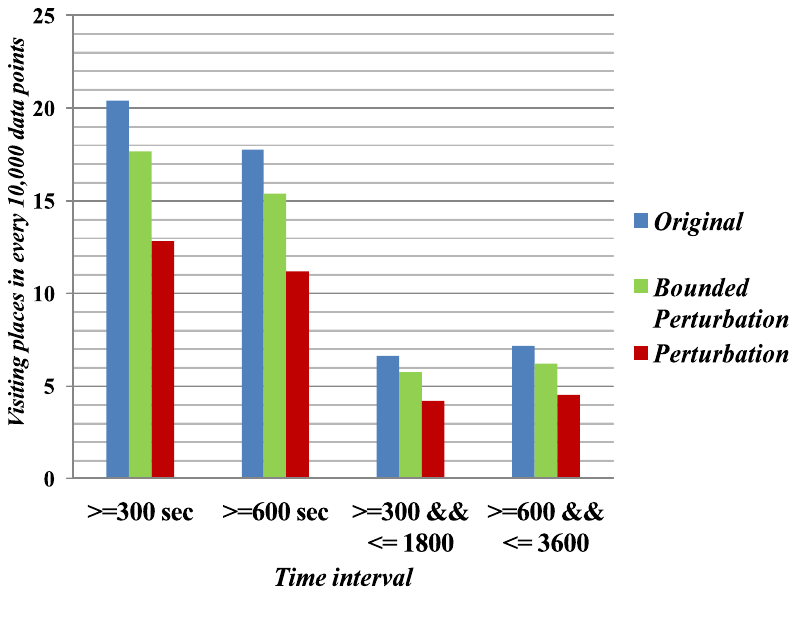
Figure 5. Visited points of interest ( PoIs ) in different time